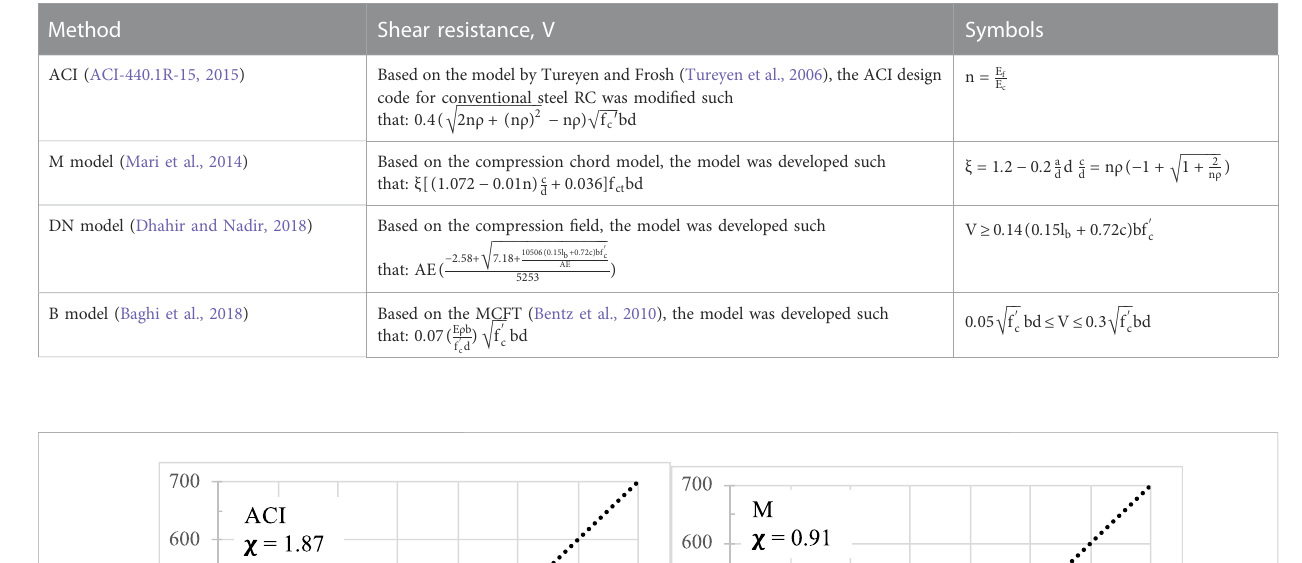
FIGURE 2 Calculated versus measured strength for existing selected